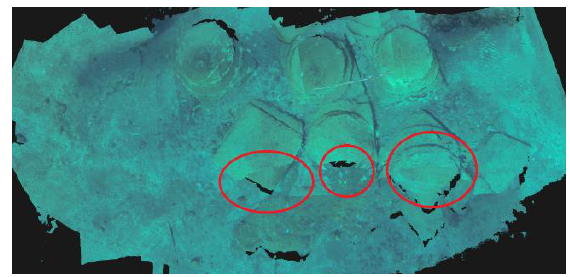
Figure 15. Lipari without global registration